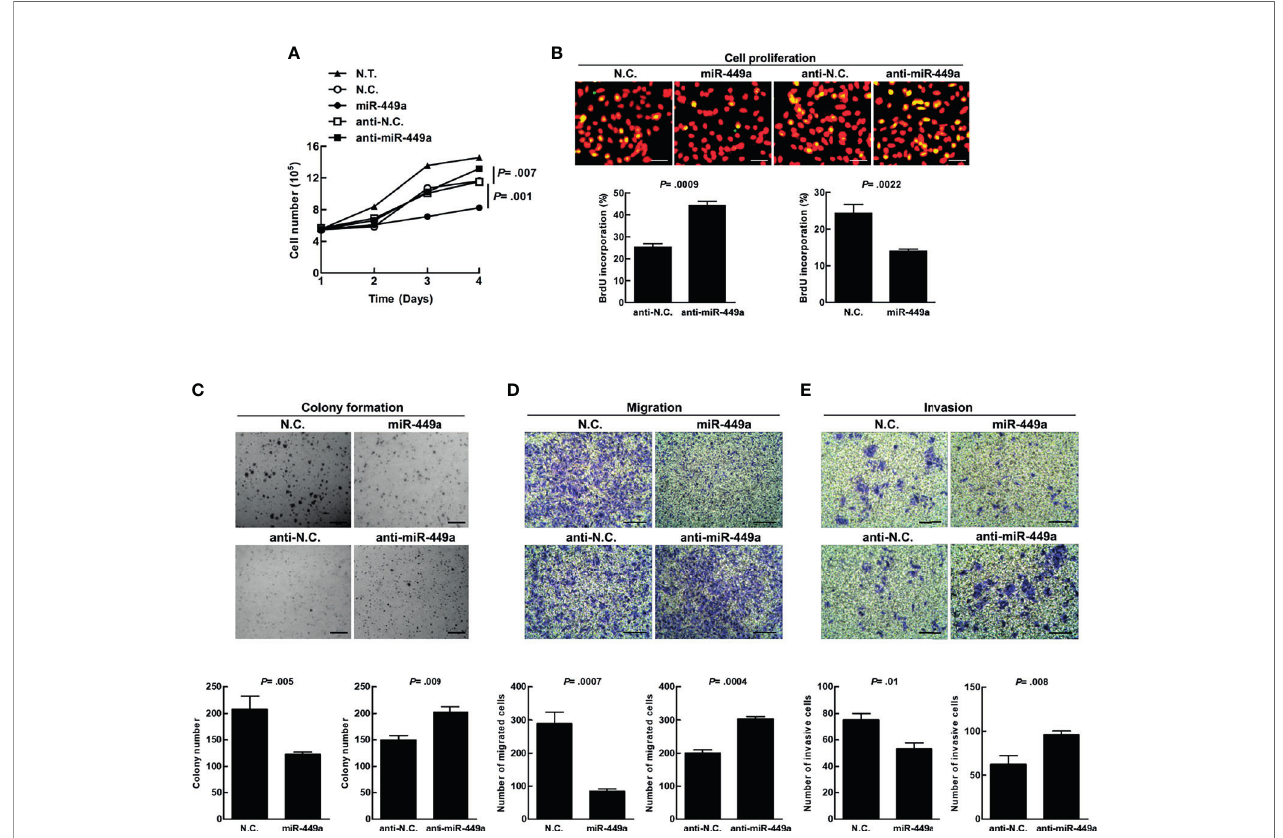
FIGURE 4 | MiR-449a suppresses tumorigenesis of CRC cells. The SW480 cells were transiently transfected with 100 nM of miR-449a, anti-miR-449a, or scramble control (anti-N.C.) for 48 h using Lipofectamine ™ 2000 reagent. (A) Cell number was counted under a light microscope. (B) DNA synthesis was determined by BrdU (0.01 g/ml) incorporation treatment of SW480 cells for 30 min. Anti-BrdU antibody and propidium iodide (PI) were used to label the treated cells for DNA synthesis and nuclei, respectively. The yellow fl uorescent cells represent proliferating cells (DNA synthesis), which were counted under three random fi elds under a fl uorescent microscope and were used to calculate the percentage of cell proliferation. (C) A total of 2×10 4 transfected cells were plated on the soft agar in a 6-well plate. The images were taken 14 days after plating. The diameter of a counted colony bigger than 0.1 mm at 9X magni fi cation was de fi ned as positive colony. Scale bar= 1 mm. (D) In the migration assay, transfected cells were seeded in the Transwell ™ permeable insert with FBS-free medium in the lower chamber. The migrated cells were counted after 48 h. (E) In the invasion assay, the transfected cells were seeded into the Transwell ™ insert coated with the matrigel. The number of invasive cells was counted after 72 h. The cells were counted under three random fi elds under a light microscope. Quanti fi cation was conducted based on three independent experiments. The p values were determined by Student ’ s t -test analysis. Scale bar= 100 m